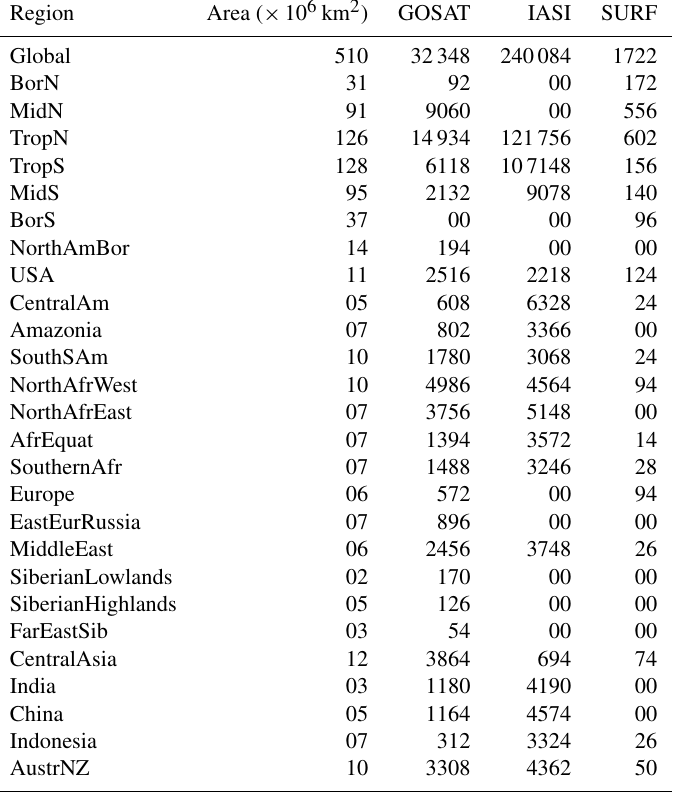
Table A1. Yearly mean number of observations over the period used for the Monte Carlo noise computation (October 2009–September 2010) in the various regions for the three observing